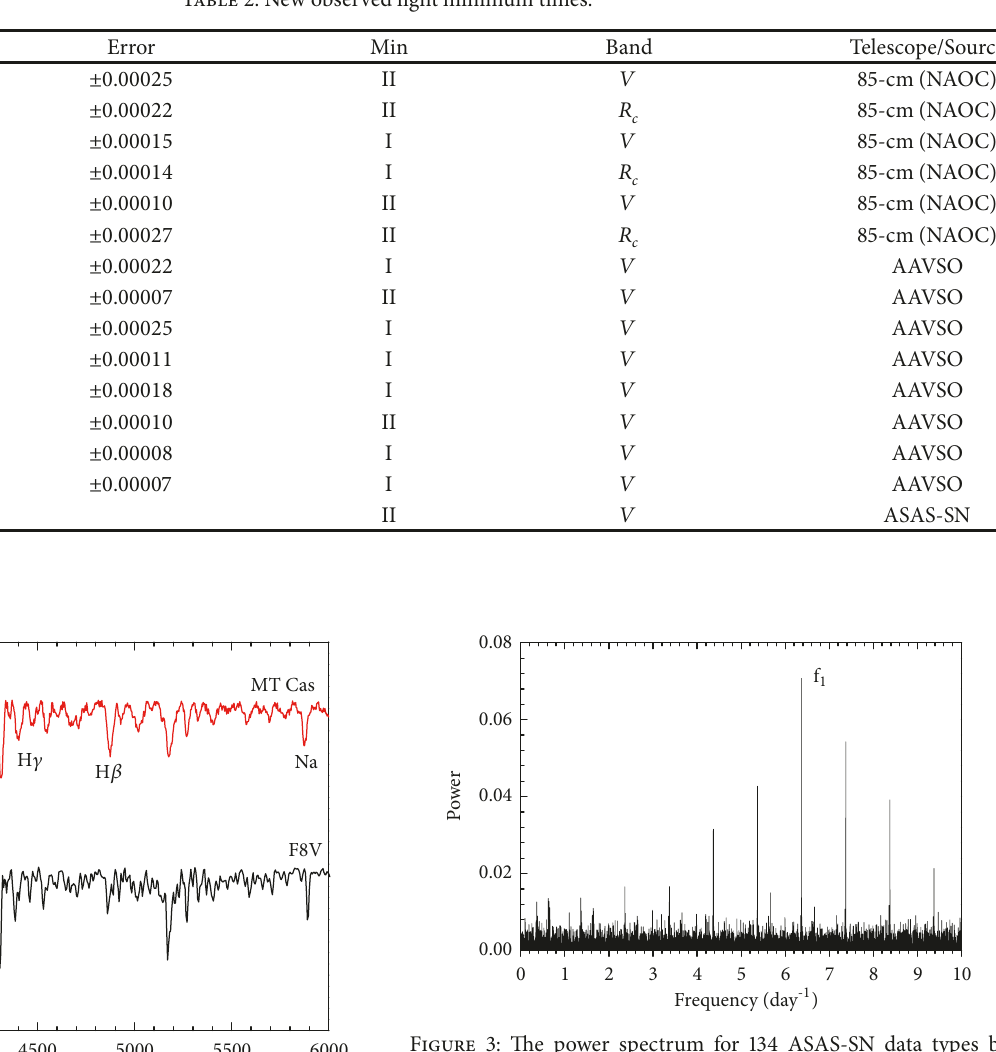
Figure 3: The power spectrum for 134 ASAS-SN data types by Fourier